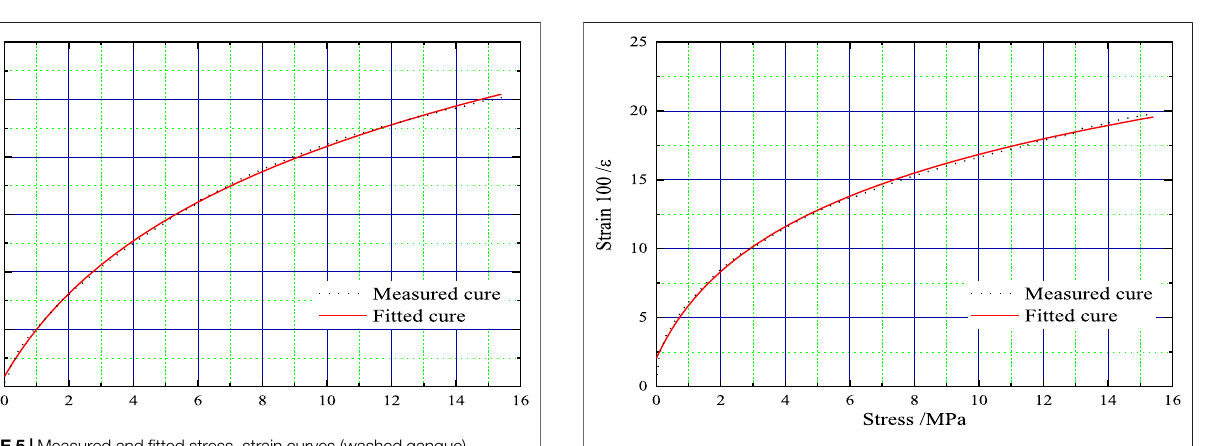
FIGURE 8 | Measured and fi tted stress – strain curves ( n (cid:1) 0.7).